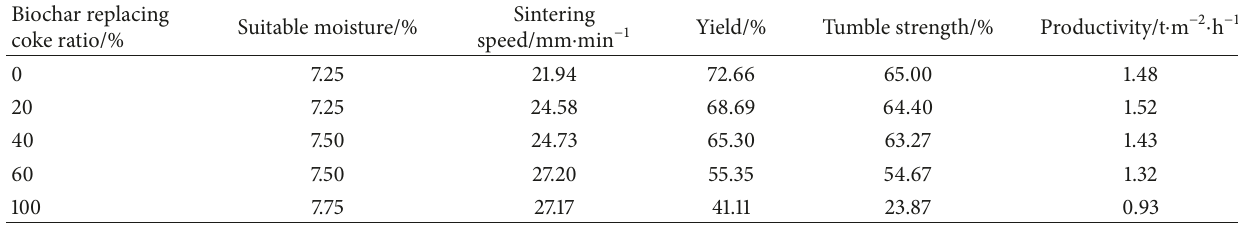
Table 4: Effect of biochar replacing coke breeze on sintering indexes.